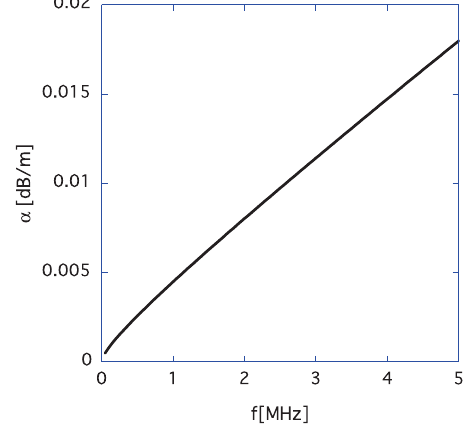
FIG. 9. The frequency dependence of attenuation parameter α Fig. 3 can be well reproduced simultaneously by choosing 0 . 015 dB = m and 20 Ω as the attenuation and the imped- ance parameters of the cable in the CST code. cable terminals) obtained with the M ICRO W AVE S OLVER of CST are shown in Fig. 10, where the wire radius is ρ 80 μ m and the twin-wire separation is Δ ¼ 60 mm. w ¼